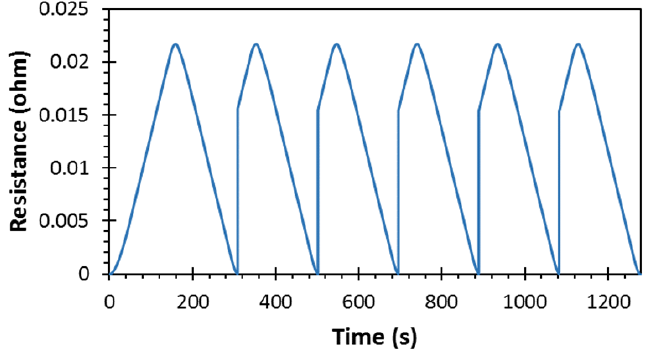
Figure 11. The electrical resistance difference between Train 2 and the train ahead or the next virtual station.